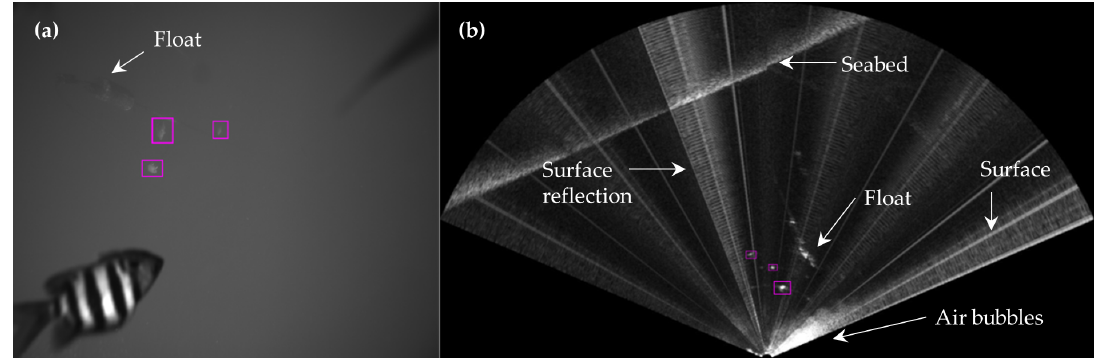
Figure 13. ( a ) Three fish automatically detected by the YOLO optical algorithm (outlined in magenta) also apparent in ( b ) BlueView multibeam sonar data (manually outlined in